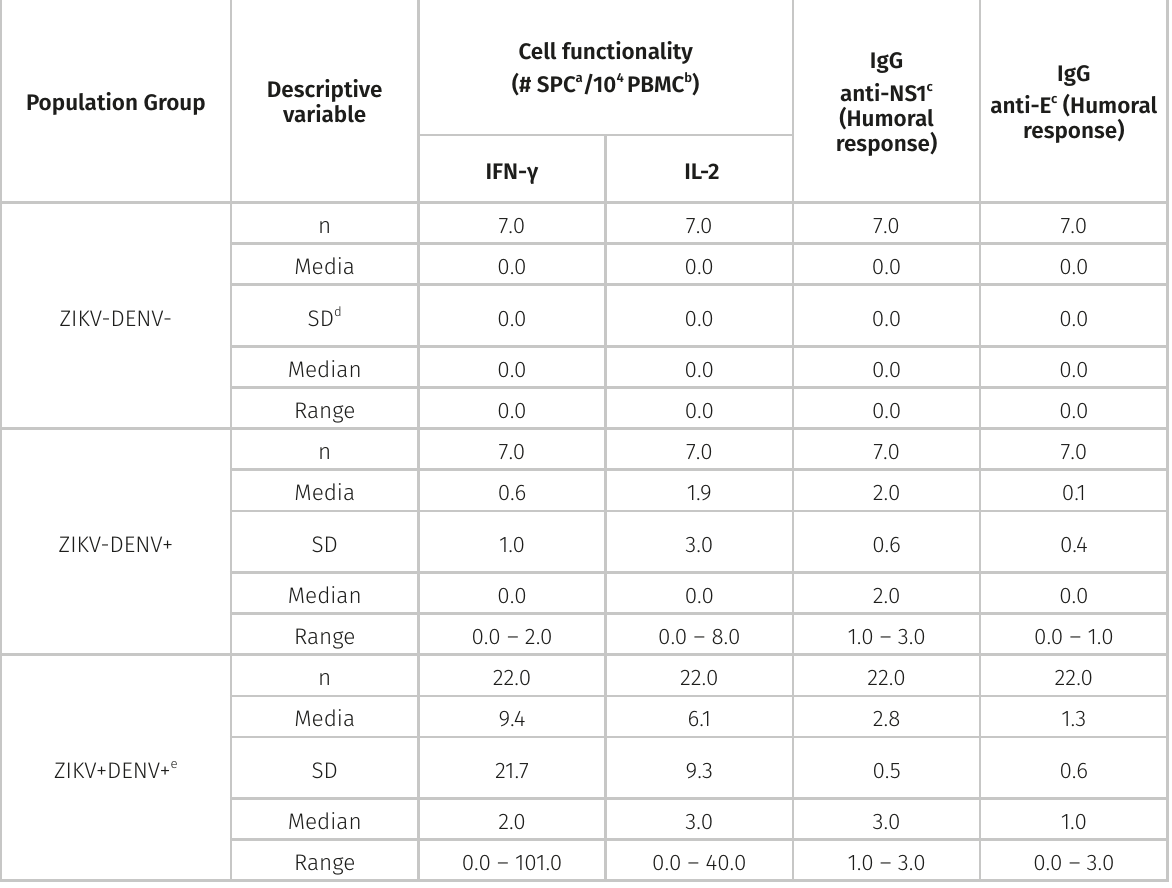
Table II. Descriptive variables for cell and humoral response between groups.